Question: Draft a figure caption describing what is shown.
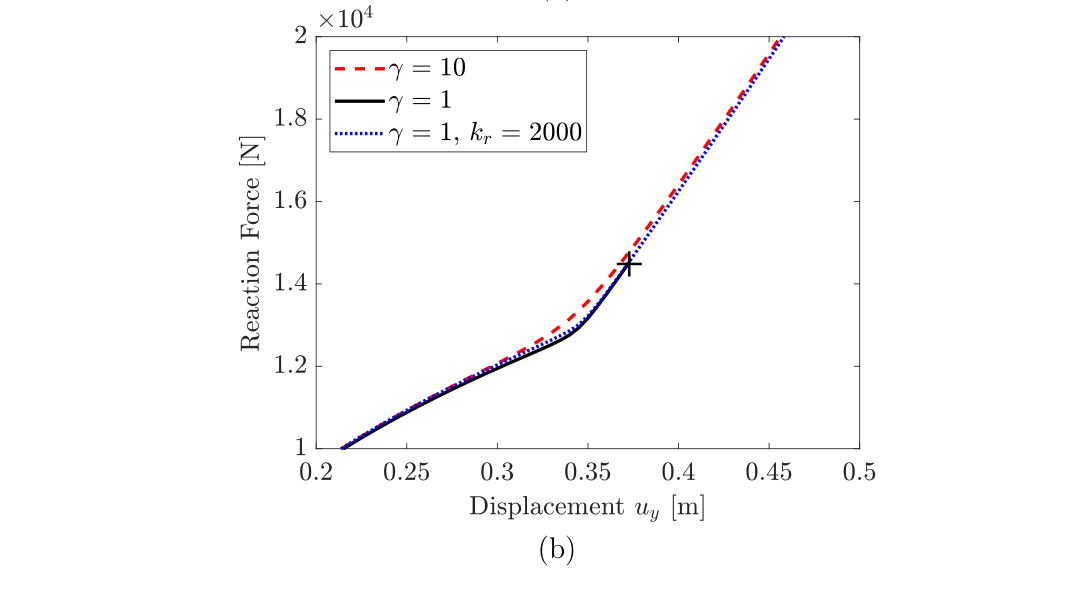
Answer: A rectangular cell loaded by a prescribed displacement, without pneumatic actuation. (a) Mesh and deformed configuration for γ = 10 (left), for γ = 1 (center), where only the last converged configuration is shown, with contact penetration and distorted third medium (see the inset), and for γ = 1 with the use of additional regularizing terms (right). (b) Comparison of force-displacement diagrams for different values of γ and regularization (only vicinity of contact initiation at uy = 0.3m shown).